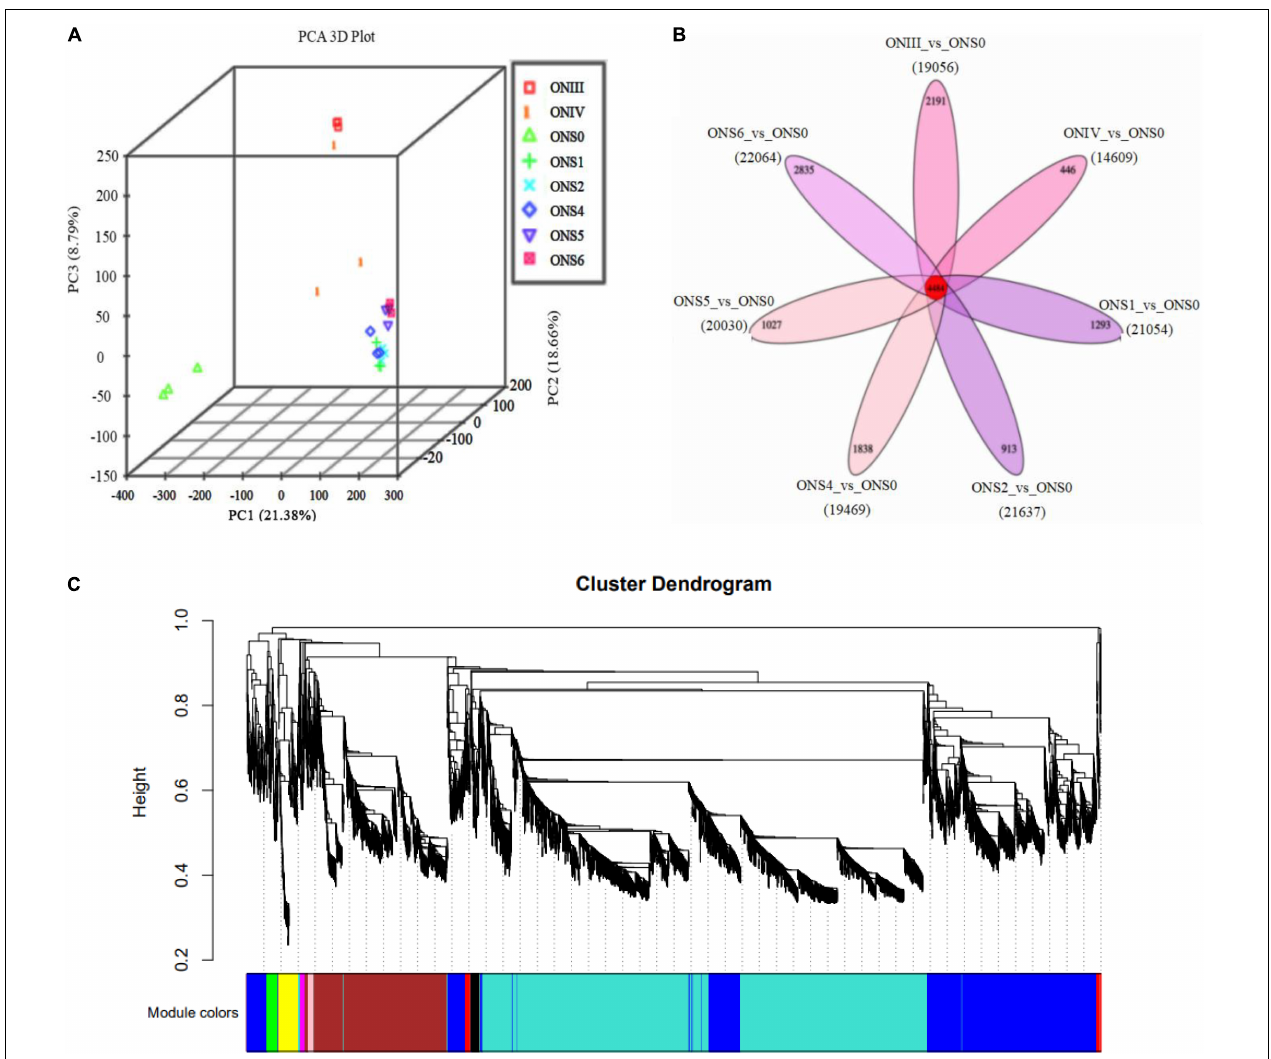
FIGURE 3 | Developmental transcriptomic profiling of V. corymbosum ‘O’Neal’ flower bud and fruit. (A) Principal component analysis (PCA) of transcriptomic profiles from 8 specific developmental stages. (B) Venn diagram illustrating the number of differentially expressed genes (DEGs) shared by or specific to flower bud and fruit development. (C) Hierarchical cluster dendrogram related to the cell numbers of outer mesocarp and columella identified by weighted gene co-expression network analysis